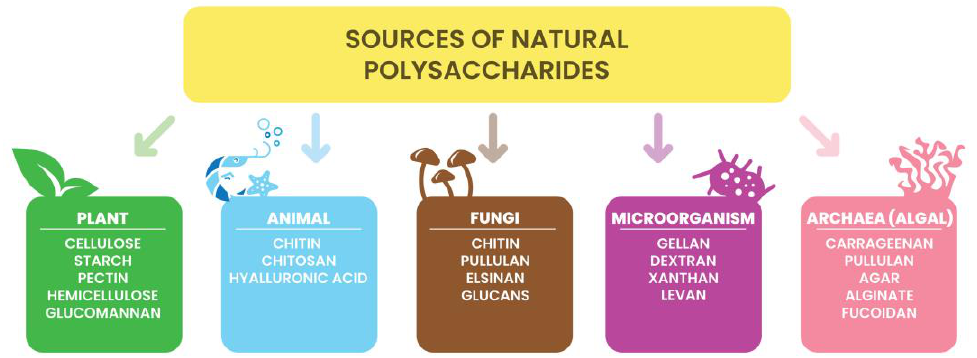
Figure 2. Resources of natural polysaccharides with antibacterial and bacteriostatic properties.